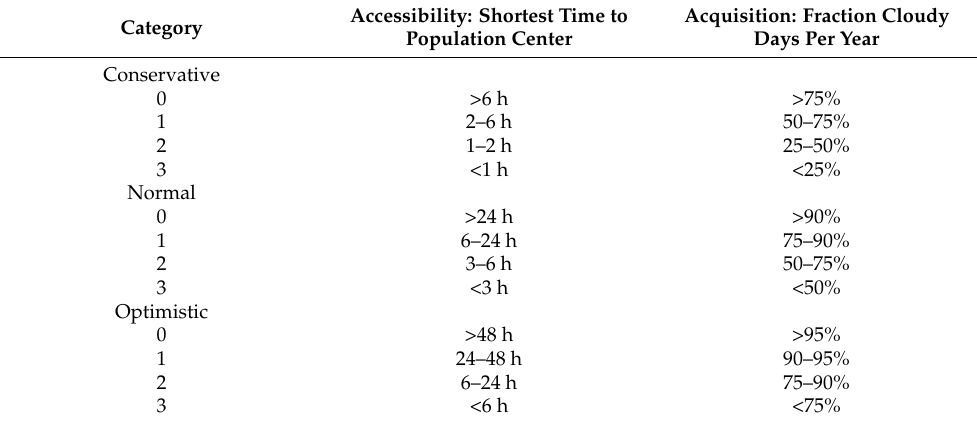
Table 3. Cost-payoff matrix for modeling potential of remote sensing for watershed monitoring.